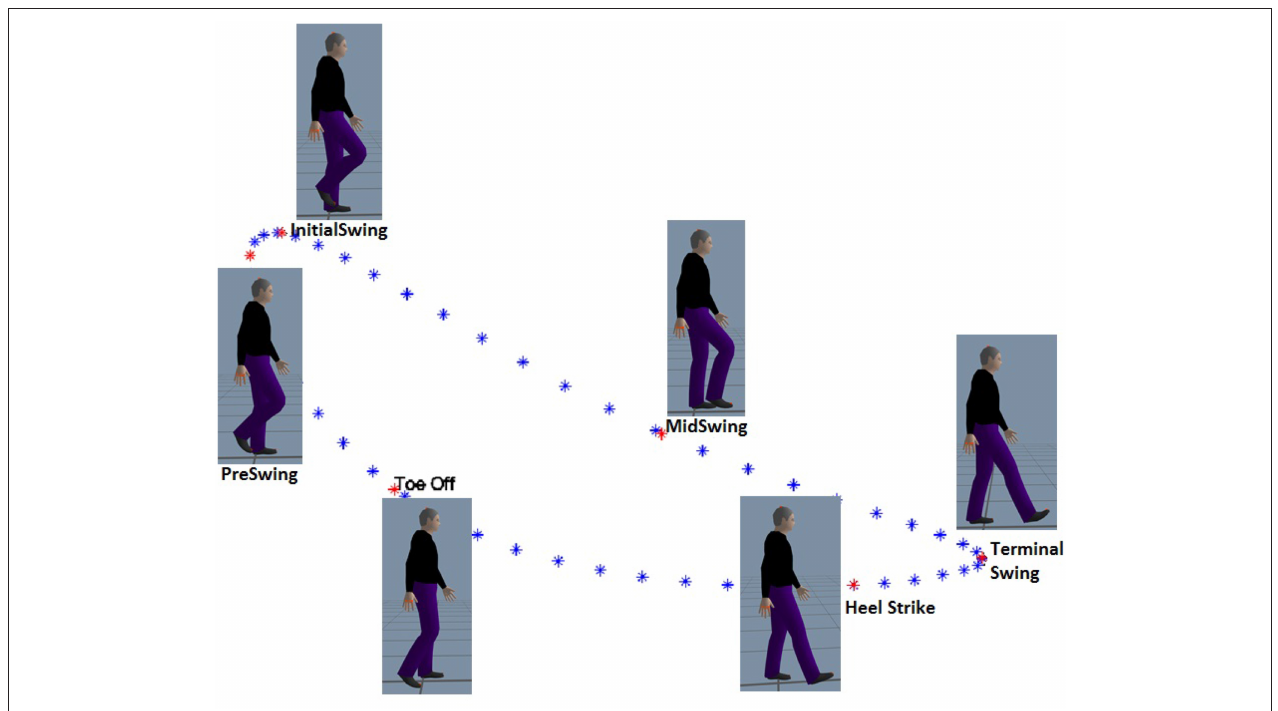
FIGURE 2 | Defined key events are sequenced in order of occurrence: Heel Strike, Toe Off, Pre-Swing, Initial Swing, Mid-Swing, Terminal Swing. The position of the ankle in the sagittal plane is shown. Additionally, the approximate angular position of the hip and knee joints can also be seen in the cartoons.